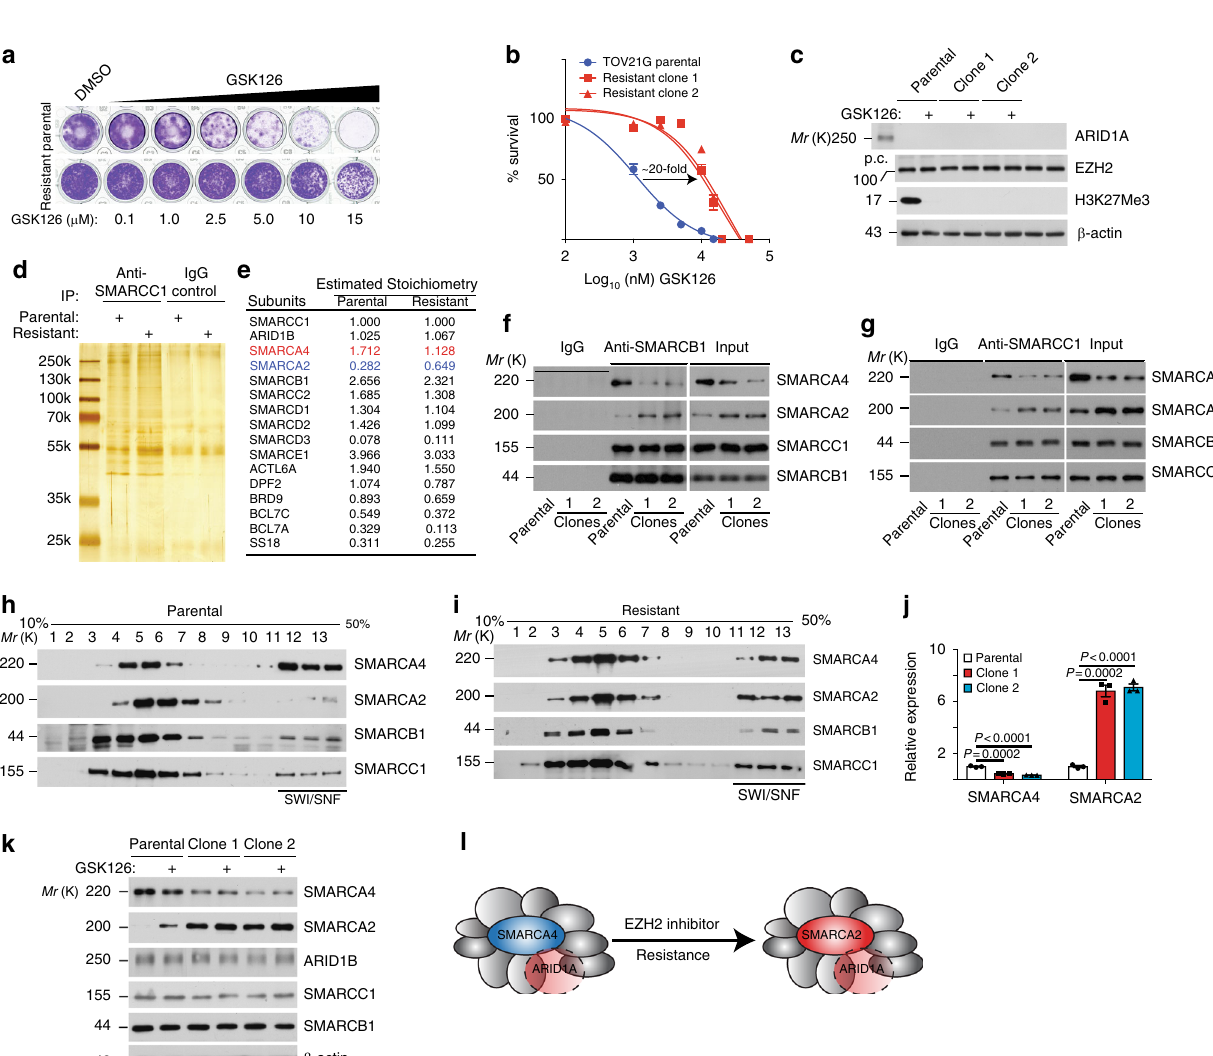
identi fi ed a list of 394 direct SMARCA4 target genes upregulated in EIR cells (Fig. 3d). Pathway analysis revealed that the top pathways that are suppressed in EIR cells were cell death and apoptosis (Fig. 3e). Among the cell death/apoptosis signature, the anti-apoptosis gene BCL2 is a direct SMARCA4 target whose SMARCA4 occupancy in the promoter region was reduced and its expression was signi fi cantly upregulated in EIR cells (Fig. 3f